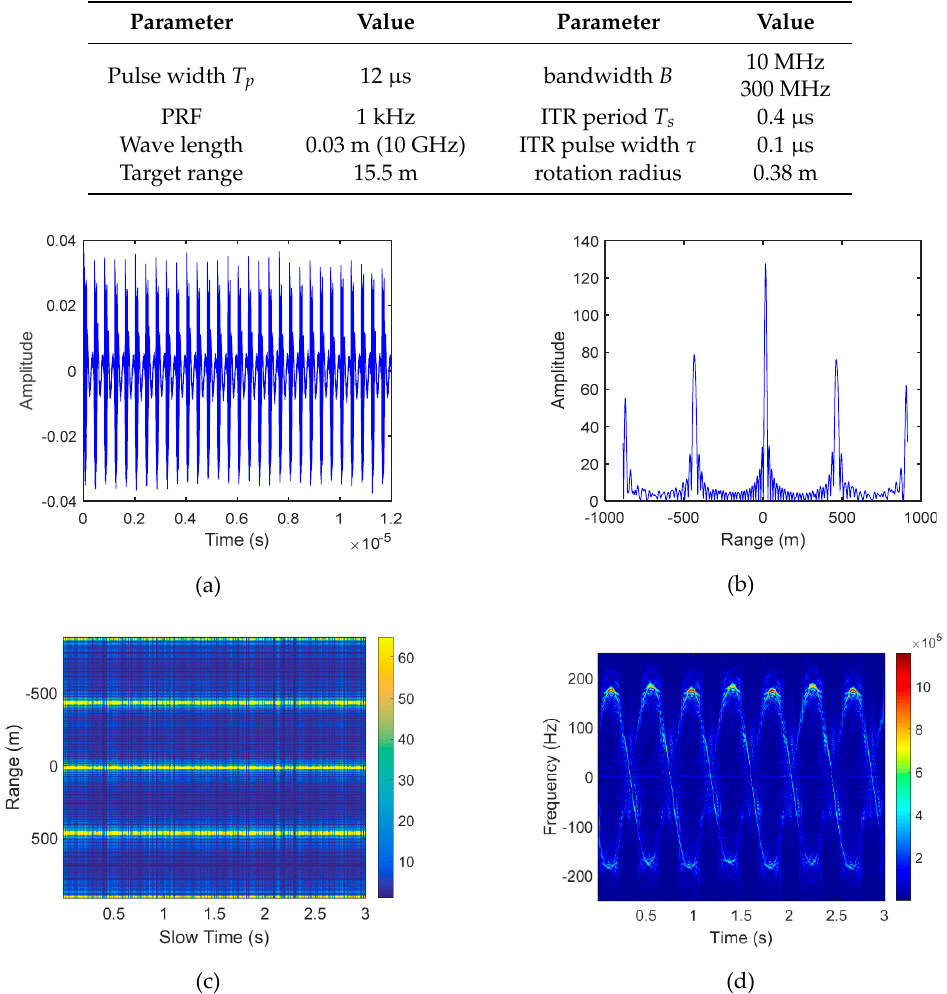
Table 2. Parameter setting of uniform transmitting and receiving period for rotating target.